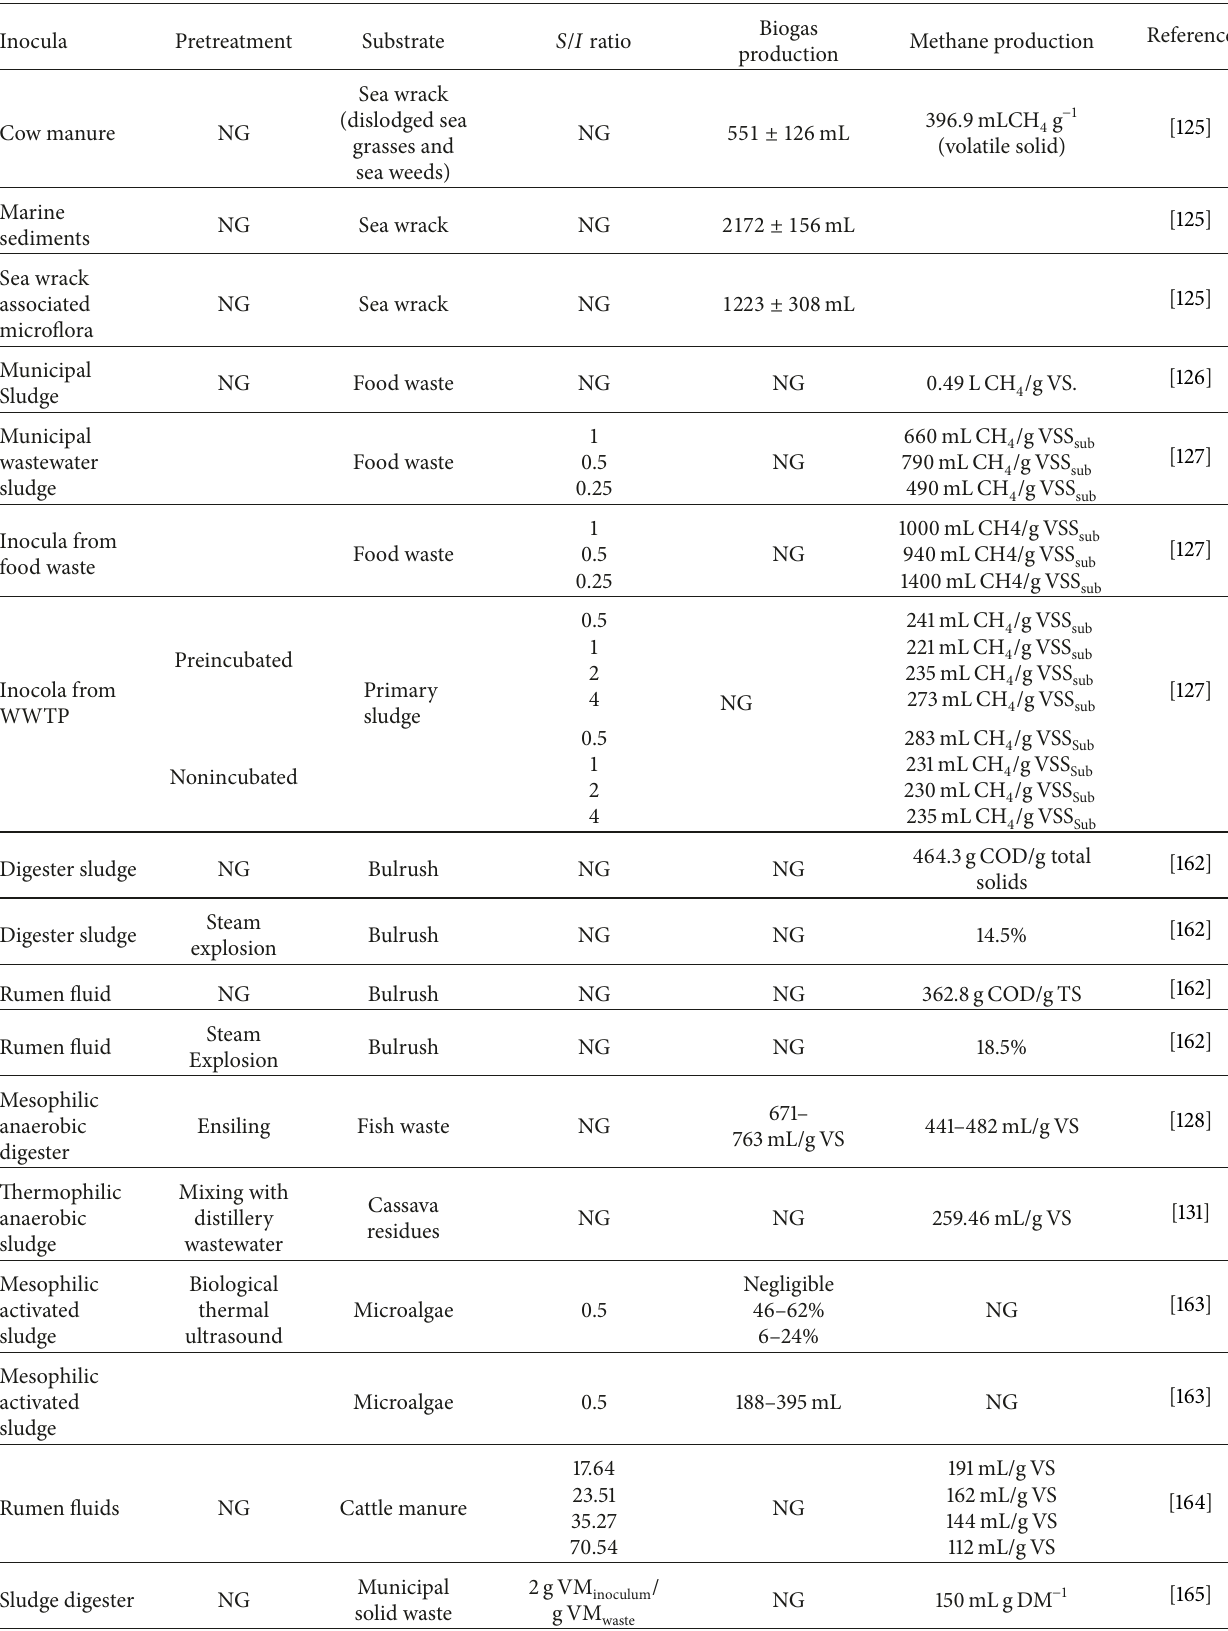
Table 4: Various inocula along various substrates and their potential for biogas